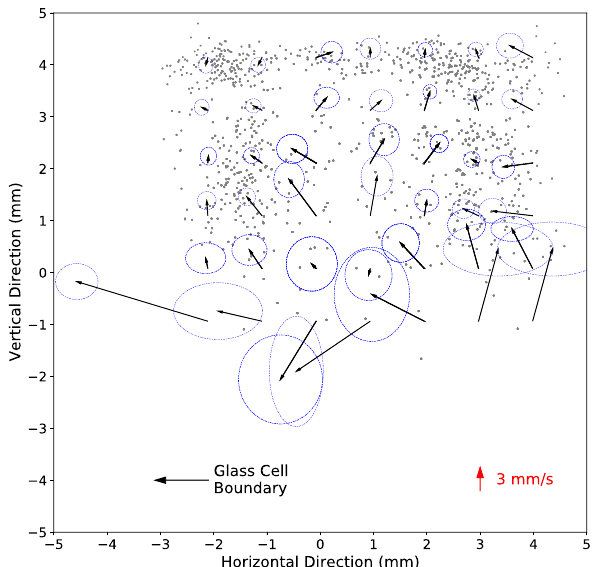
Figure 5. Box averaging of velocity vectors inferred from correlated-cluster-pairs (gray dots show locations of ~ 4800 cluster-centroid-pairs) from all images acquired at 7.3 mW heater power. An arrow indicates the mean velocity of correlated-cluster-pairs inside a 2 mm × 2 mm box (an example is the red box) centered at the origin of the arrow. The axes of the ellipse at the apex of the arrow represent the standard error on the mean for the two components of the velocity vector. The box was scanned in steps of 1 mm to produce the